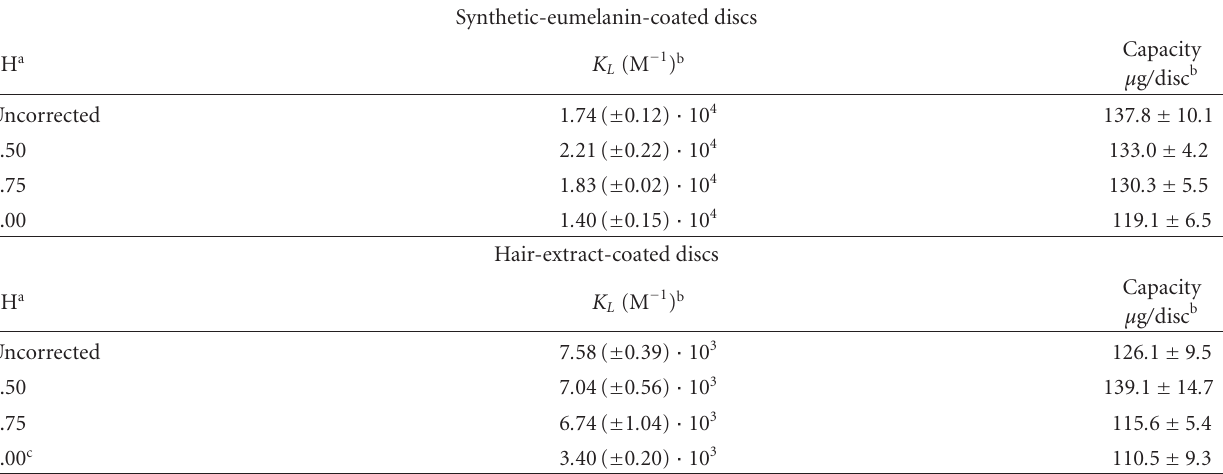
Figure 3: (a) Binding isotherm of Cu 2+ ions to synthetic-eumelanin-coated discs; titration of Cu(NO 3 ) 2 · 2.5H 2 O in 50 mM NaNO 3 (aq.) at initial pH 4.75. (b) Binding isotherm of Cd 2+ ions to synthetic-eumelanin-coated discs; titration of Cd(NO 3 ) 2 · 4H 2 O in 50mM NaNO 3 (aq.) at initial pH 4.75. (c) Binding isotherm of Zn 2+ ions to synthetic-eumelanin-coated discs; titration of Zn(NO 3 ) 2 · 6H 2 O in 50mM NaNO 3 (aq.) at initial pH 4.75. (a–c) Data are average values from at least three independent titrations, each with di ff erent discs; error bars represent one standard deviation. Table 1: Lead-binding